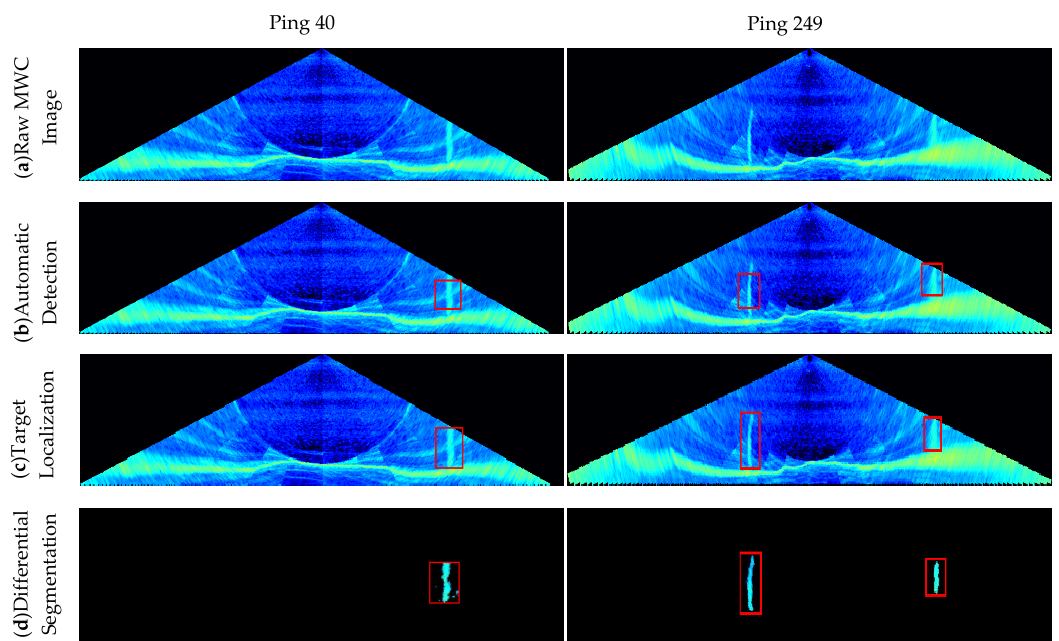
Figure 19. Experimental results of two representative deep-water MWC images by the proposed method. ( a ) Raw MWC images; ( b ) gas plumes detected by the given automatic detection algorithm; ( c ) the exact target-box locations obtained by the target localization algorithm; ( d ) gas plumes segmented by the differential segmentation algorithm and morphological constraint algorithm.